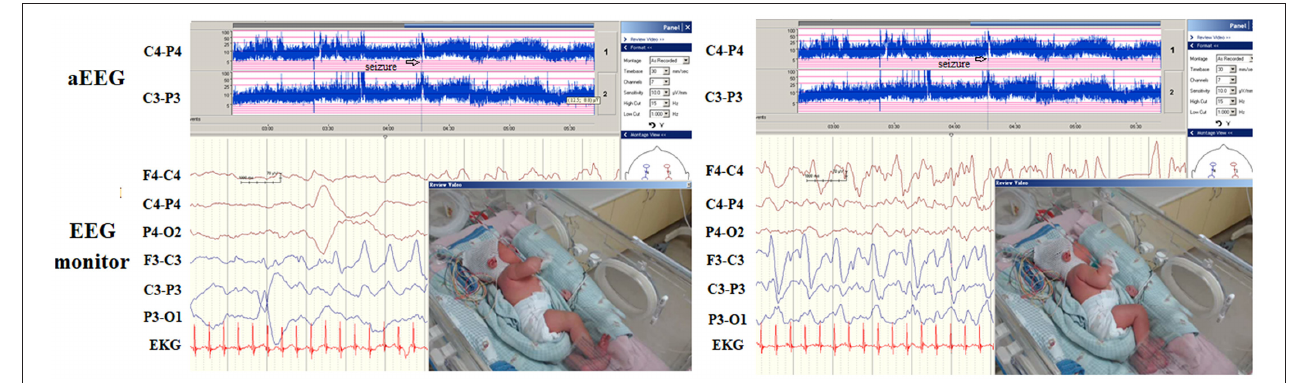
FIGURE 4 | Hypocalcemic seizure since day 8 of birth in one newborn. The automated electroencephalography (aEEG) and electroencephalography (EEG) monitoring revealed three seizures within 1h (arrows) with the aEEG background initially lower, then upflected. His calcium level was 6.8 mg/dL (ion calcium, 0.71 mg/dL).